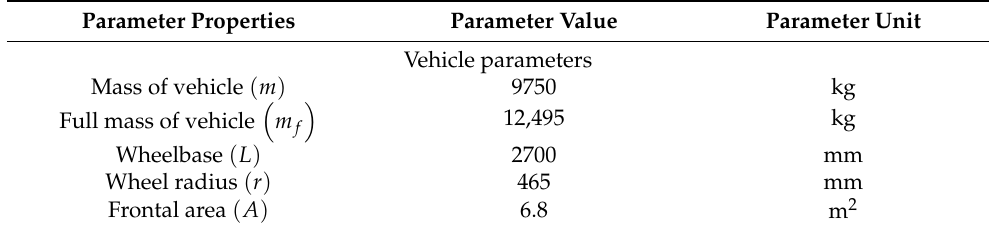
Table 1. Basic parameters of the